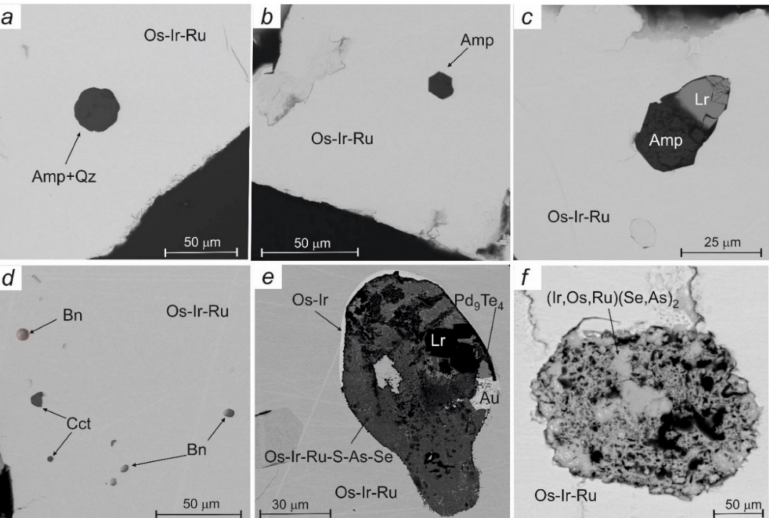
Figure 6. BSE images showing of inclusion in Os-Ir-Ru alloys: ( a ) drop-shaped inclusion interpreted to represent a silicate melt; ( b ) inclusion of magnesio-hornblende (Amp); ( c ) two-phase inclusion of magnesio-hornblende (Amp) and laurite (Lr); ( d ) base-metal sulfide inclusions: bornite (Bn) and chalcocite (Cct); ( e ) polyphase inclusion with idiomorphic laurite (Lr) and telluropalladinite in intergrowth with gold (Au) in a mixture of arsenoselenides and sulfides IPGE with a thin border of Os-Ir composition; ( f ) inclusion filled with arsenoselenides of the